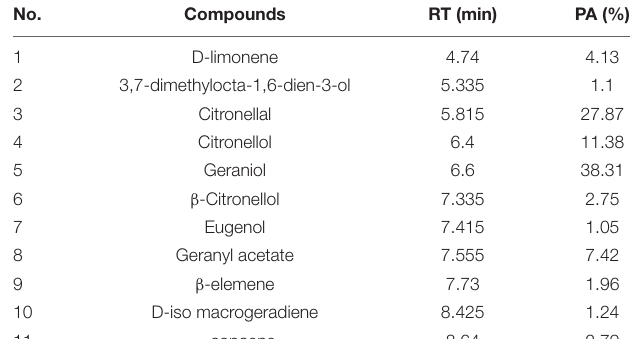
TABLE 1 | The sequence of primers. Target gene